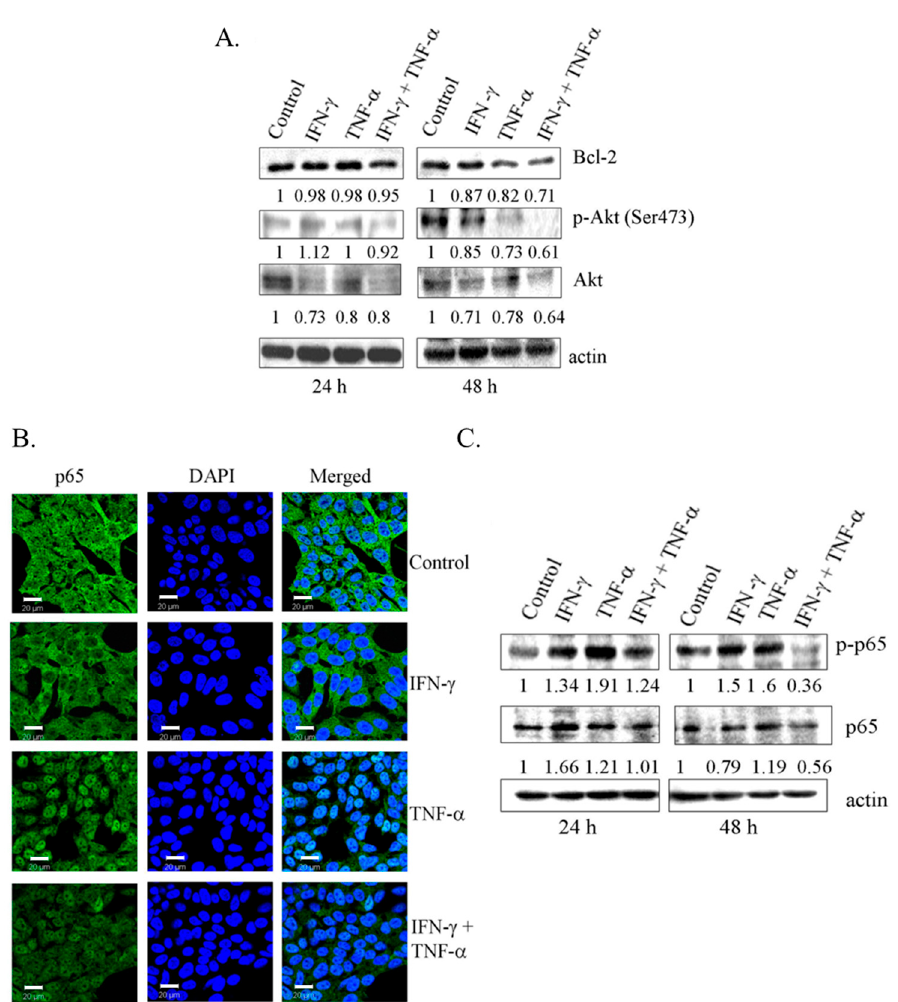
Figure 4. Down-regulation of anti-apoptotic proteins in SK-N-MC cells treated with the combination of IFN- γ and TNF- α . ( A ) SK-N-MC cells were treated with IFN- γ (10 ng/mL) and TNF- α (20 ng/mL) alone and in combination for 24 h and 48 h. Lysates were subjected to SDS-PAGE, followed by western blot analysis with the antibodies indicated; ( B ) SK-N-MC cells grown on glass cover slips were exposed to IFN- γ (10 ng/mL) and TNF- α (20 ng/mL) and in combination for 48 h, and analyzed for the localization NF- κ B/p65 by immunofluorescence (Bar = 20 µm); and ( C ) immunoblotting analysis. Bcl-2: B-cell lymphoma-2; Ak mouse strain thymoma: Akt.